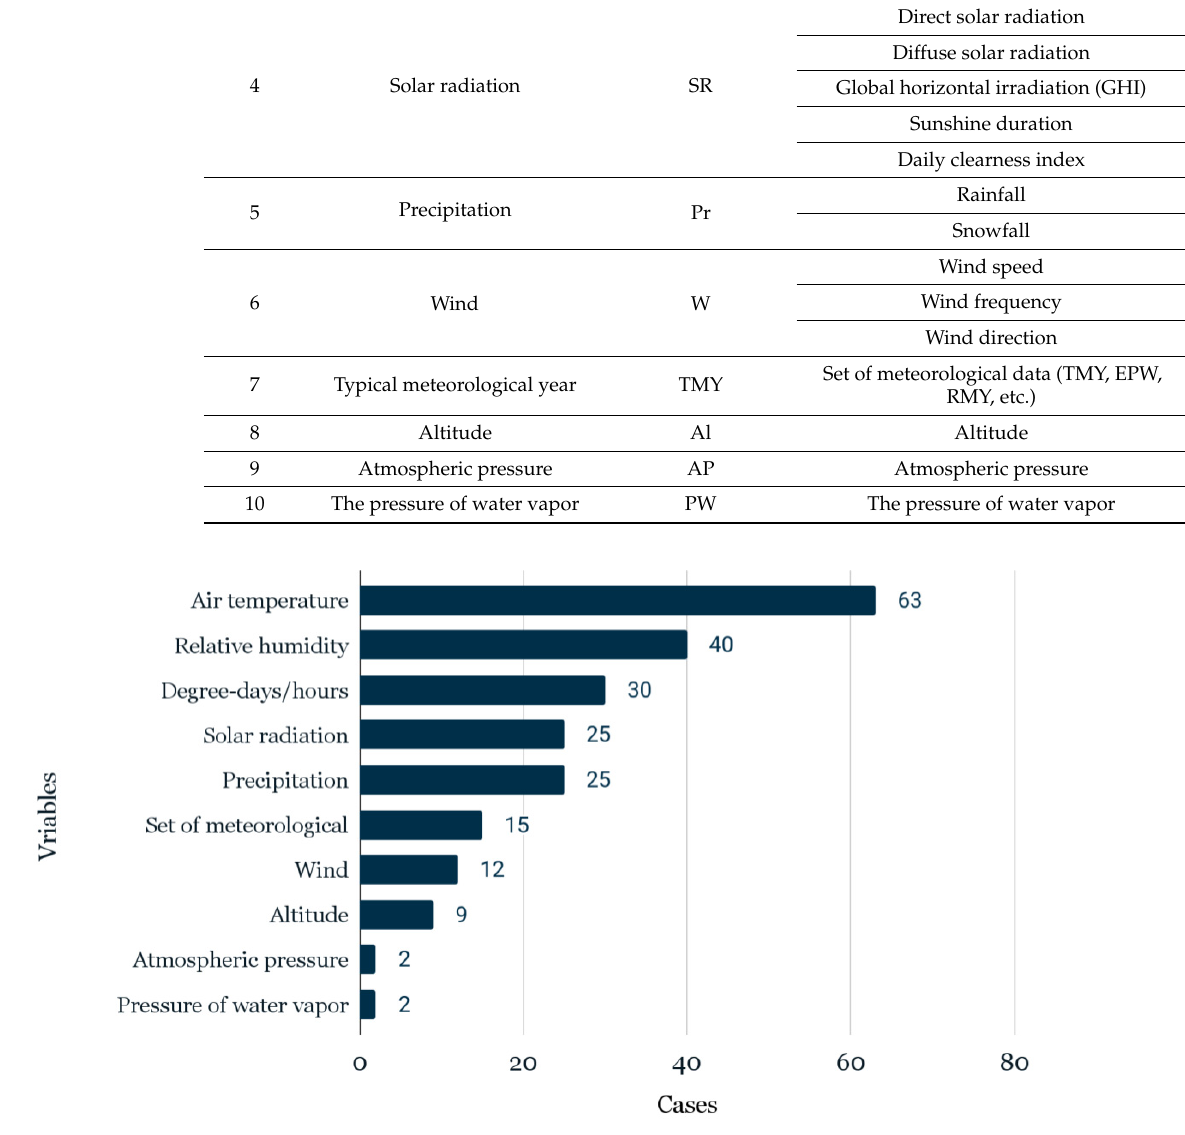
Figure 4. Main variables for CZB.